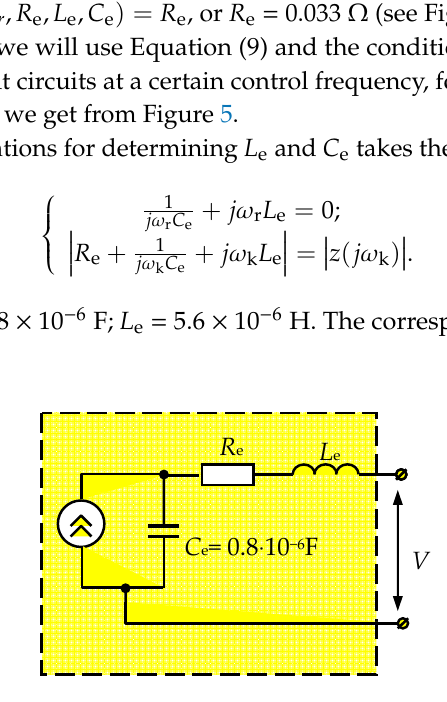
Figure 6. Solar panel equivalent circuit.